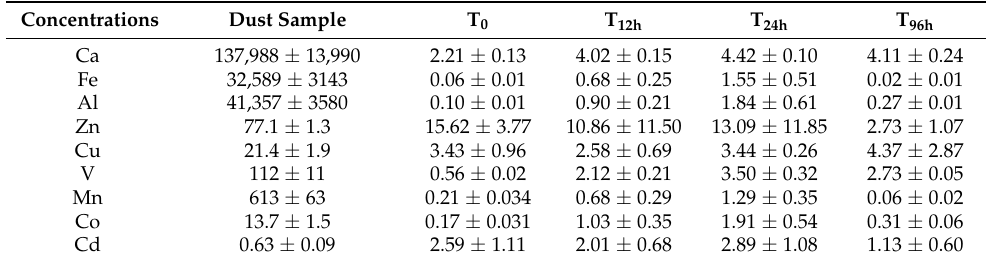
Table 2. Total metal concentrations ( µ g g − 1 ) in dust analogue collected in northern Negev and percent release relative to initial content in the particulate phase during incubation experiments (T 0 , T 12h , T 24h and T 96h ) and the respective